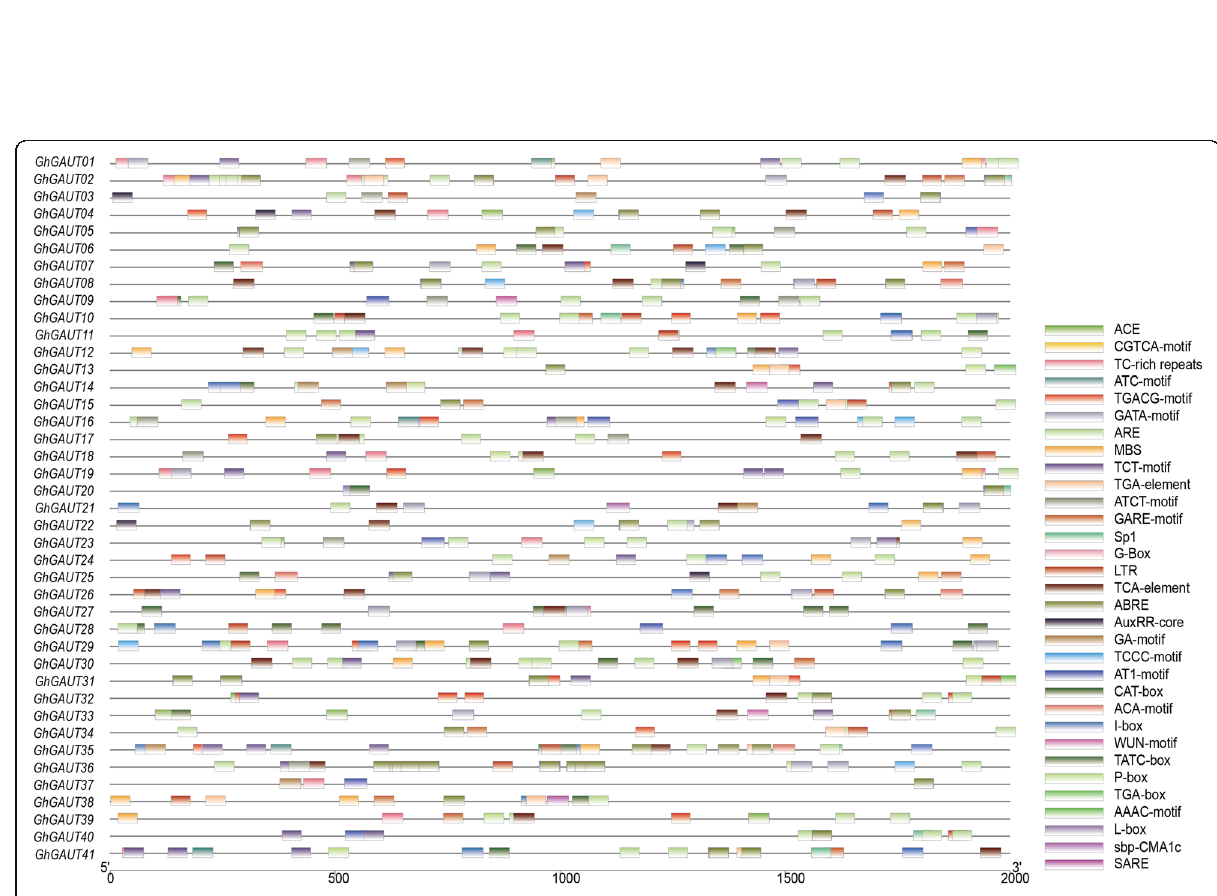
Fig. 7 Analysis of cis -elements in GhGAUT genes. 32 cis -elements in upland cotton genes were analyzed, namely, elements responsive to anaerobic conditions, different hormones (Me-JA, GA, SA, ABA and IAA), and abiotic stress conditions, including drought, low temperature and other stress